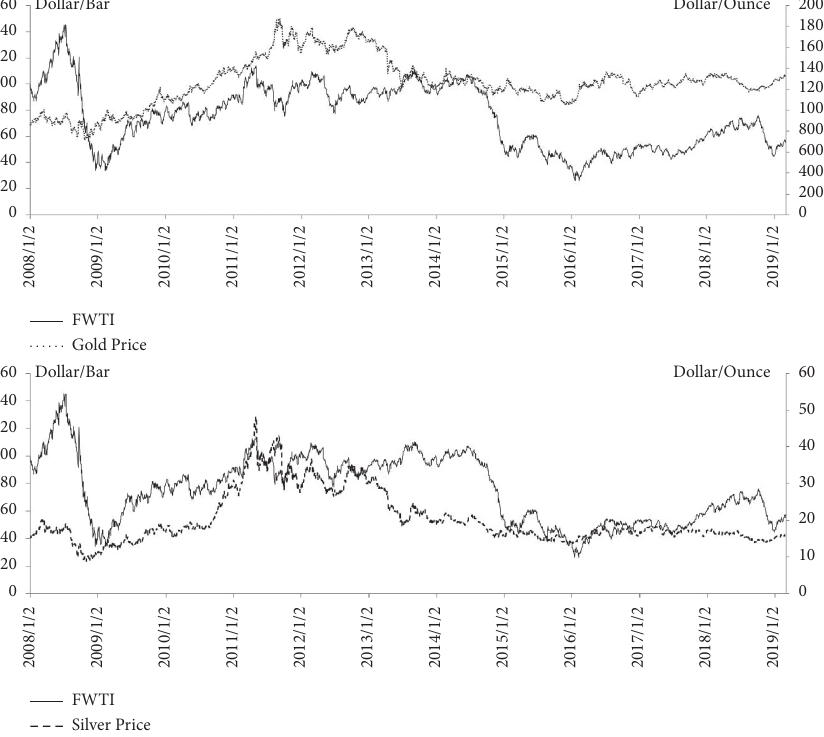
Figure 7: Relation between crude oil future prices, gold prices, and silver